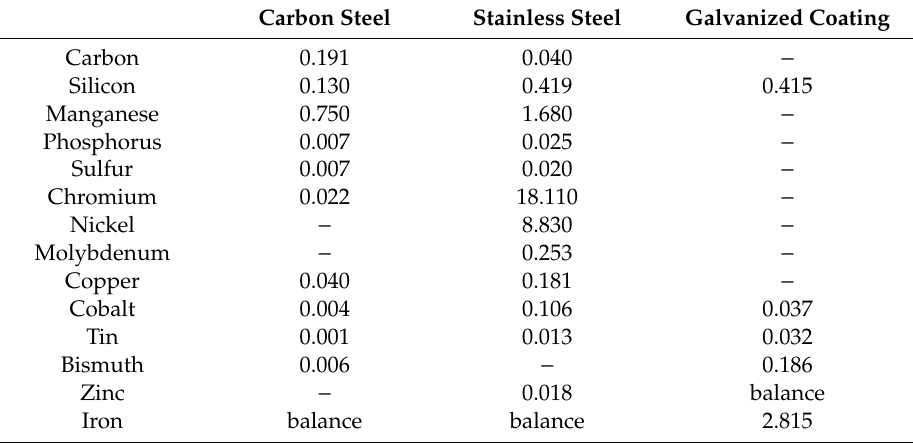
Table 1. Composition of the fasteners tested, or for the galvanized fastener, the composition of the galvanized coating. Composition is given as a weight